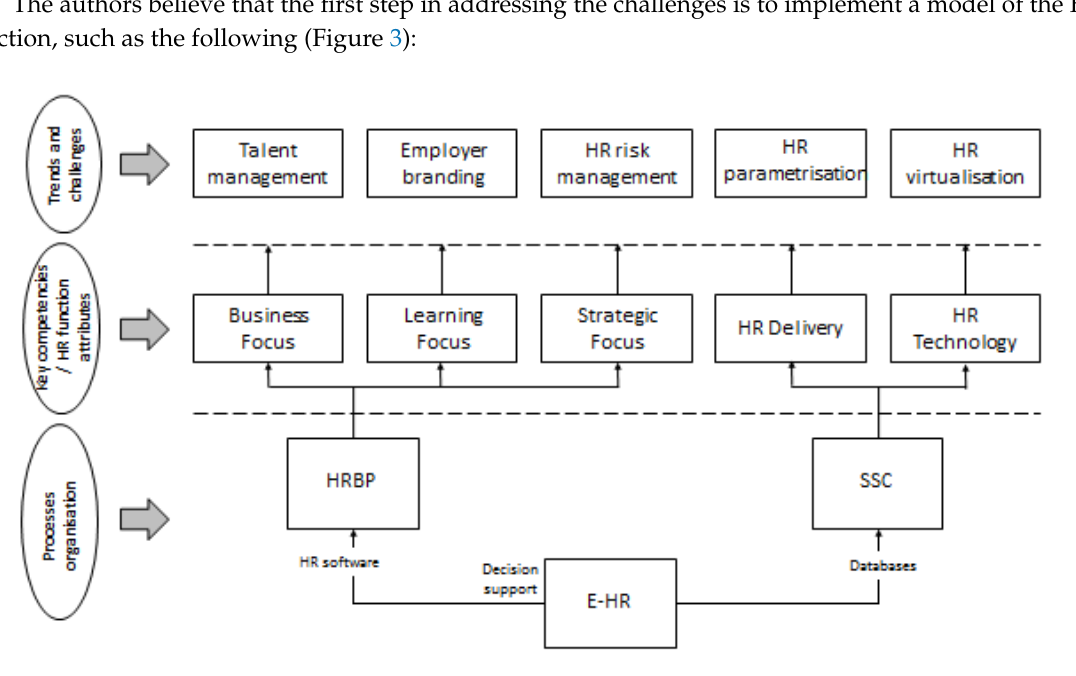
Figure 4. Schematic diagram of the personnel function in logistics management. Source: a uthors’ original work.